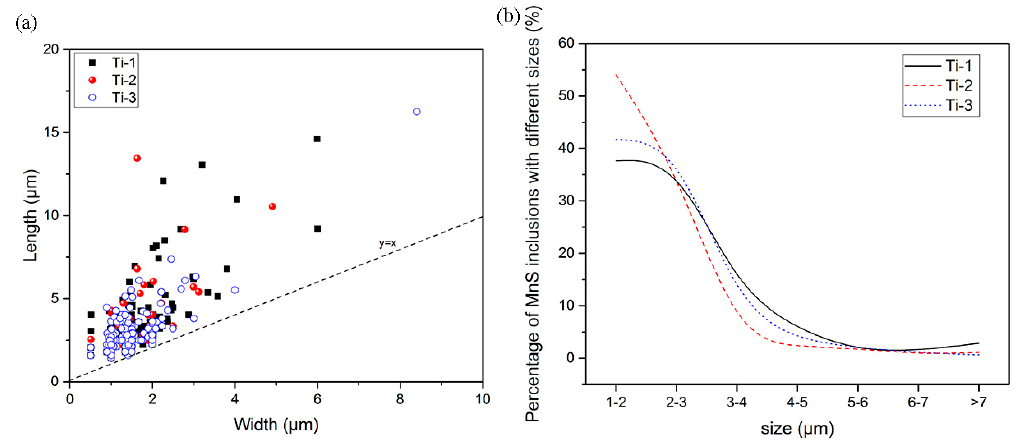
Figure 6. Aspect ratios ( a ) and size ( b ) of MnS inclusions in the samples.